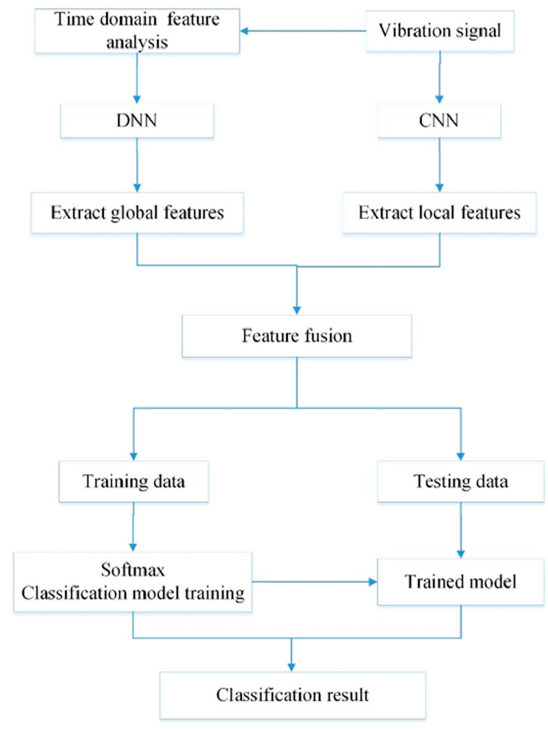
Figure 4. Fault diagnosis process of CNNEPDNN model.